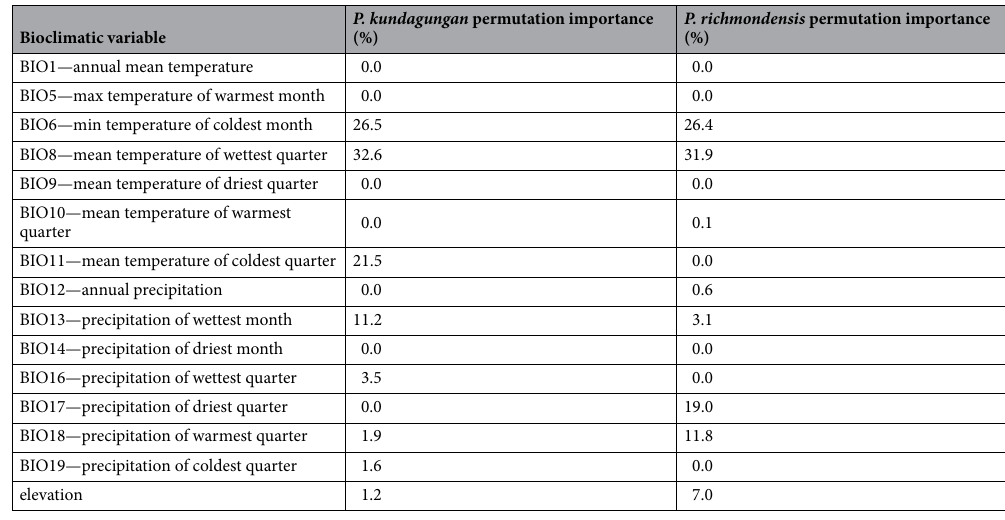
Table 1. Variables used in modelling current and future distributions of P. kundagungan and P. richmondensis and their permutation importance